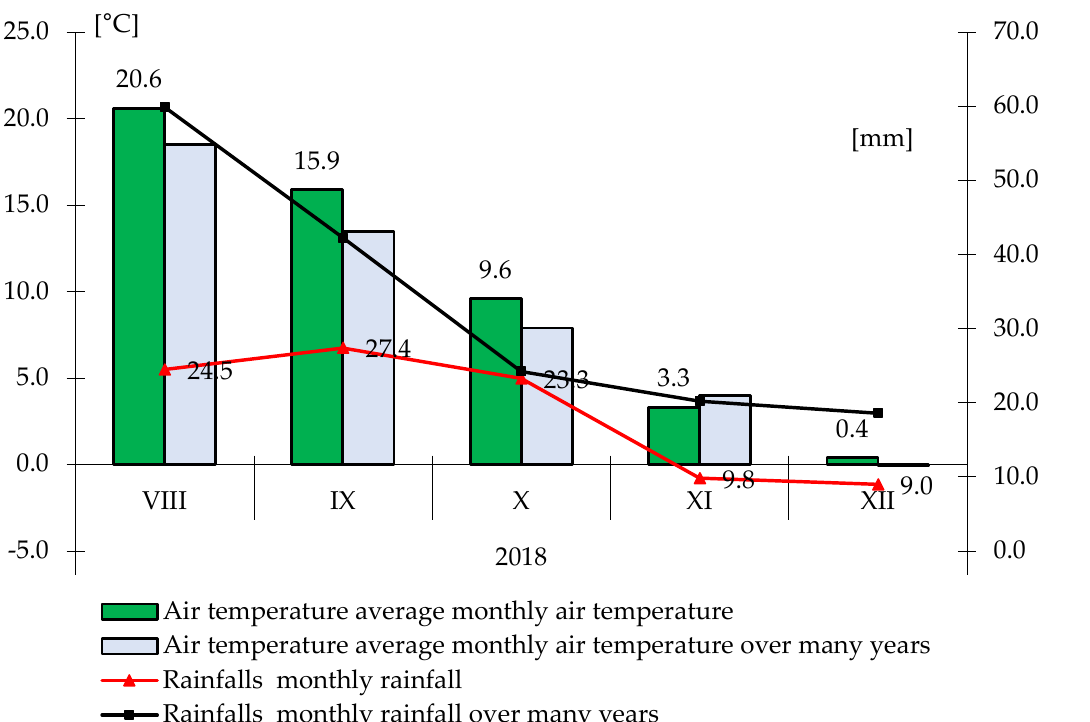
Figure 1. Monthly rainfall totals and average air temperature during the growing season 2018.